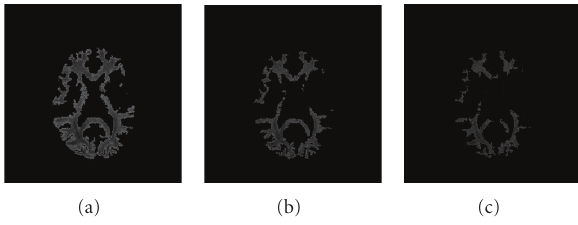
Figure 1: From left to right the weight β in increases such that the segmented region becomes smaller, and therefore we obtain purer